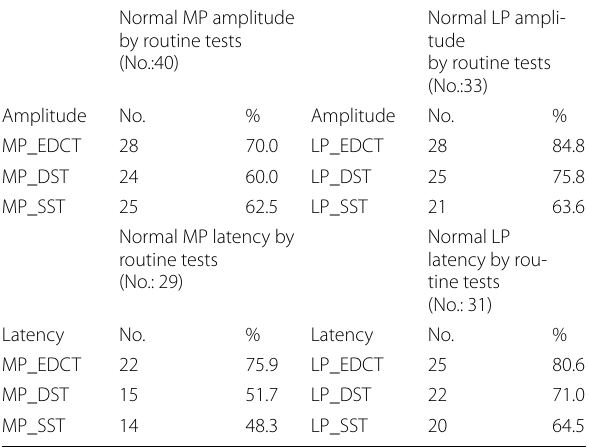
Table 2 Number (No.) and percentage (%) of positive results by the novel tests among those with negative routine tests for diagnosis of